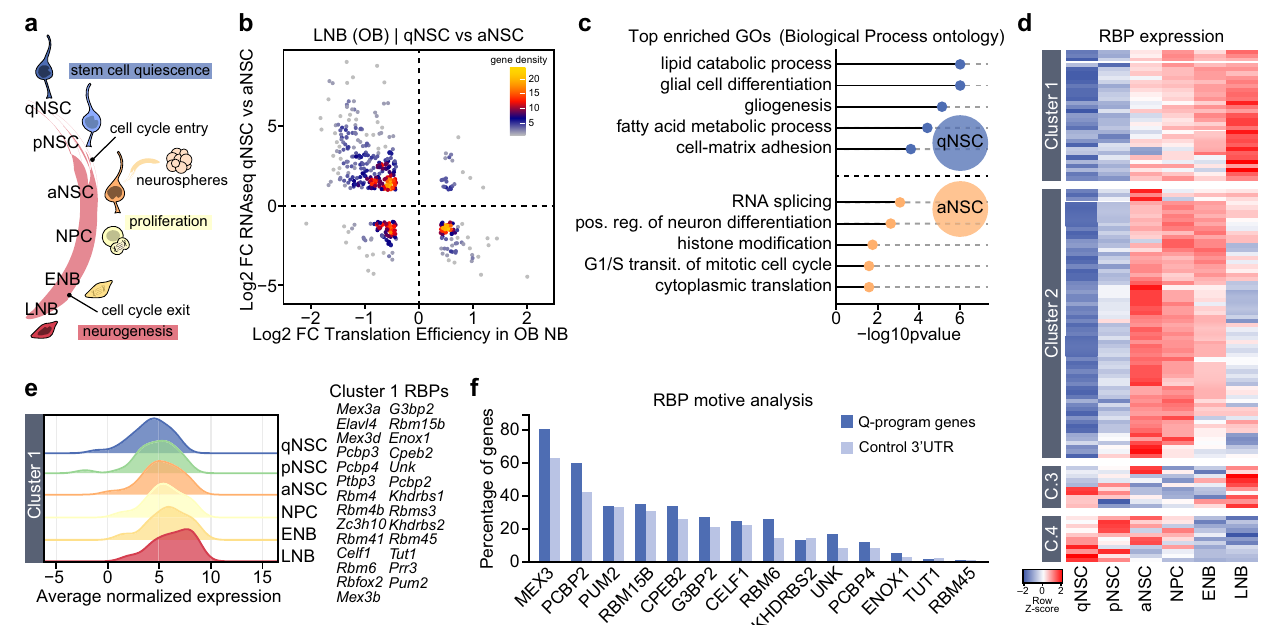
Fig. 1 | Post-transcriptional control of a NSC stemness/gliogenic signature during neural lineage differentiation. a Schematic drawing representing the cell populationsintheadultSEZneurogeniclineage(qNSC:quiescentneuralstemcells; pNSC: primed NSC; aNSC: activated NSC; NPC: neural progenitor cell; ENB: early neuroblast;LNB:lateneuroblast).AdultNSCcanbeculturedandexpandedinvitro as clonal aggregates, neurospheres. Cell cycle entry and exit points along the lineage are highlighted. b Scatterplot comparing differential expression (DE) data fromisolatedqNSCvs.aNSCpopulations 12 withtranslationef fi ciencydatafromOB